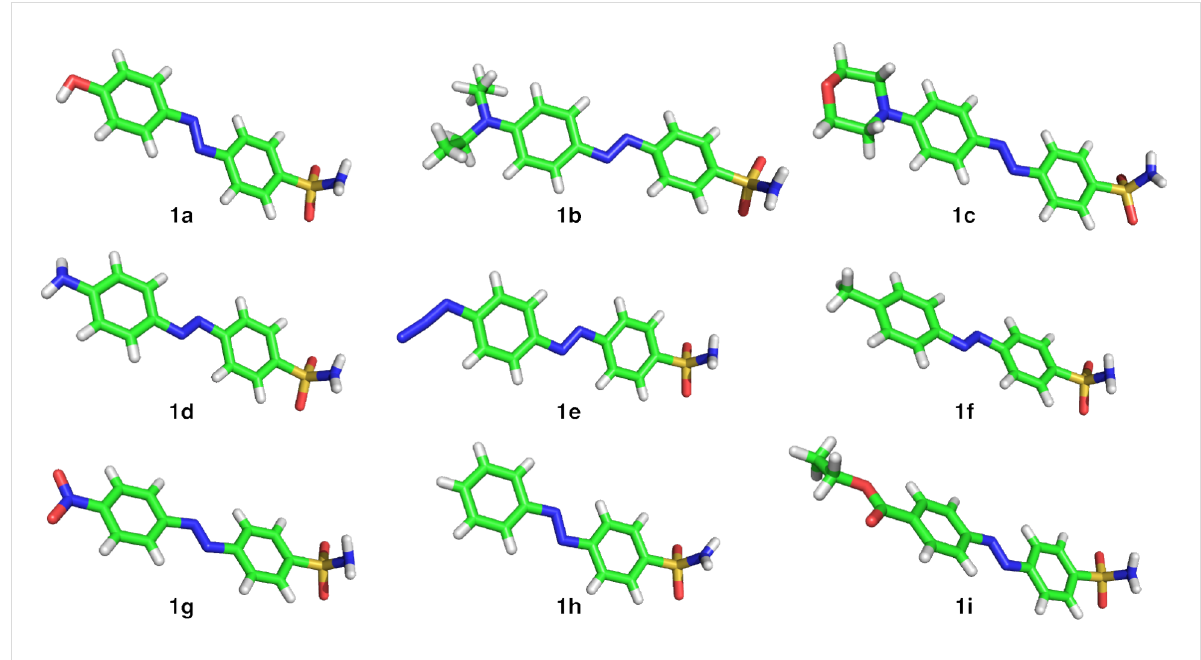
Figure 2: Crystal structures for compounds 1a – i (co-solvents and/or multiple molecules in the asymmetric cell are omitted for clarity).